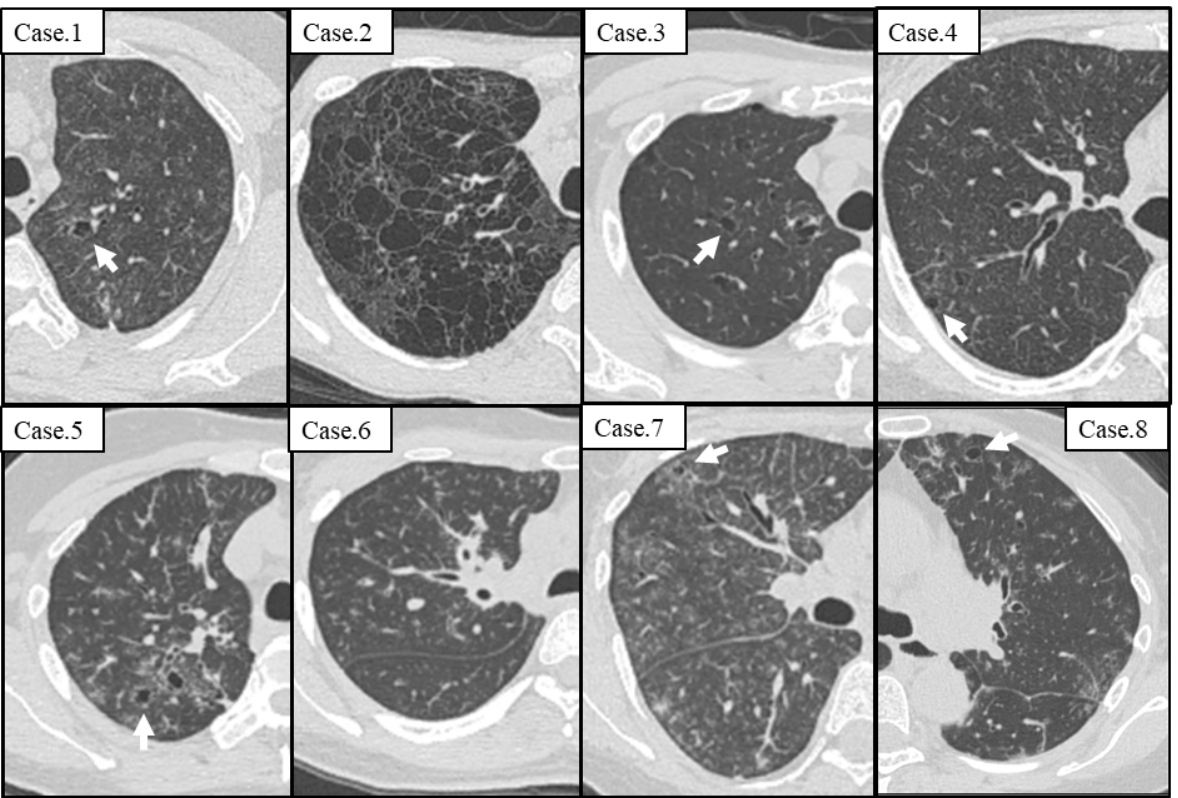
Figure 1. Cysts on Computed tomography at the first visit in 8 cases. Seven cases (87.5%) other than Case 6 had thin-walled cysts (arrow). There was ground-glass a tt enuation around cysts.